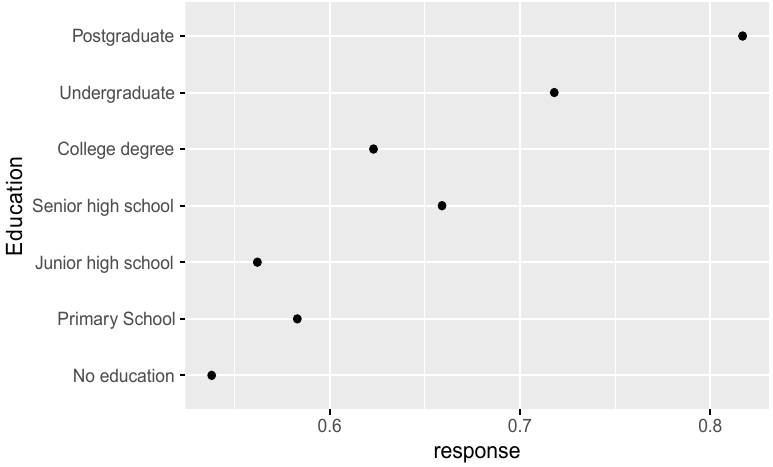
Figure 2. Zero-inflated regression coefficient of education. Figure 3. Zero-inflated regression coefficient of education. Figure 3. Zero-inflated regression coefficient of education. Figure 3. Zero-inflated regression coefficient of education.